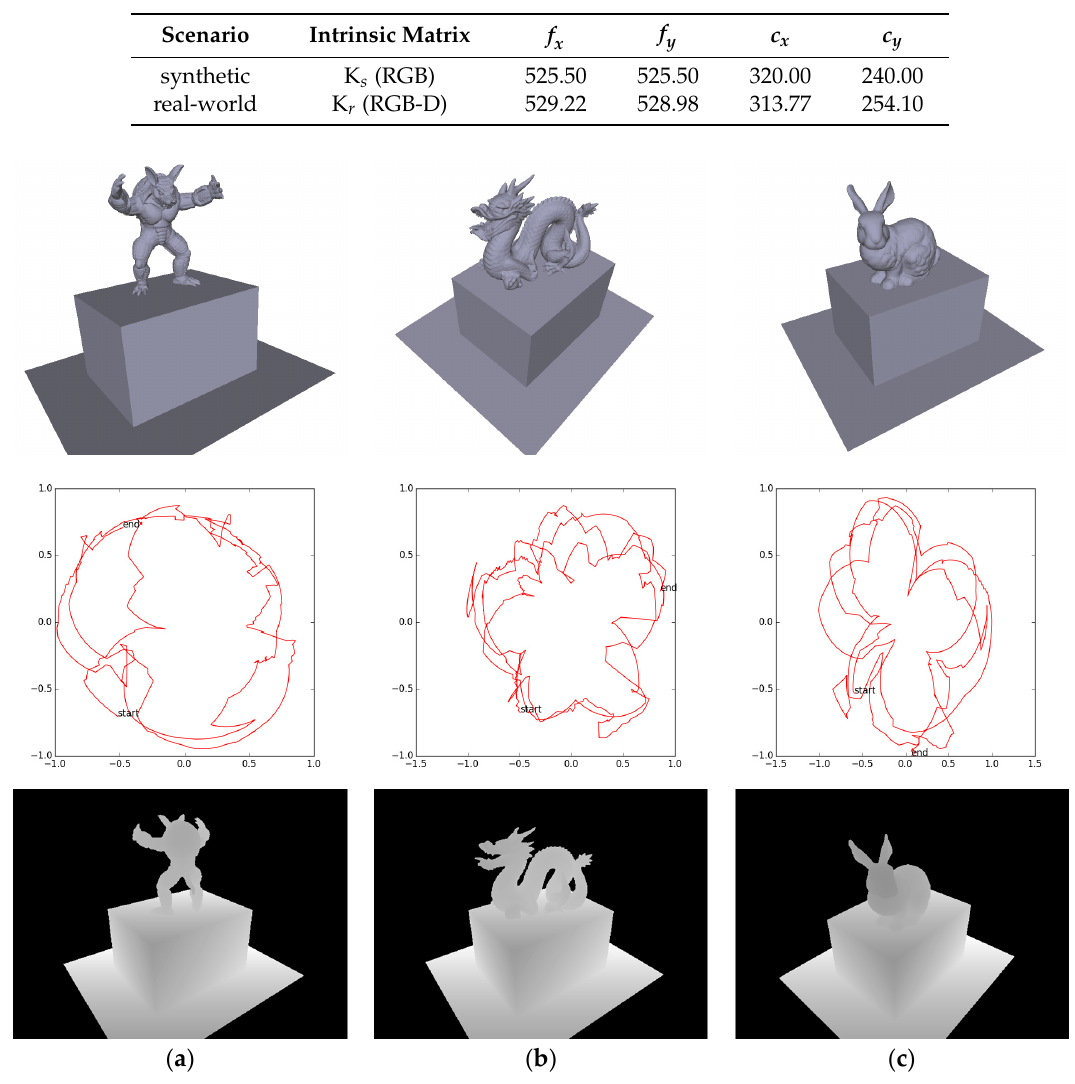
Figure 8. Synthetic data. The ( a ) armadillo; ( b ) dragon; and ( c ) bunny are set upright on top of a cuboid (400 × 300 × 250 mm 3 ) respectively. The top row shows the snapshot of the GT models, the middle row shows the GT camera trajectories (top view), and the bottom row shows the generated depth images (at time 0).